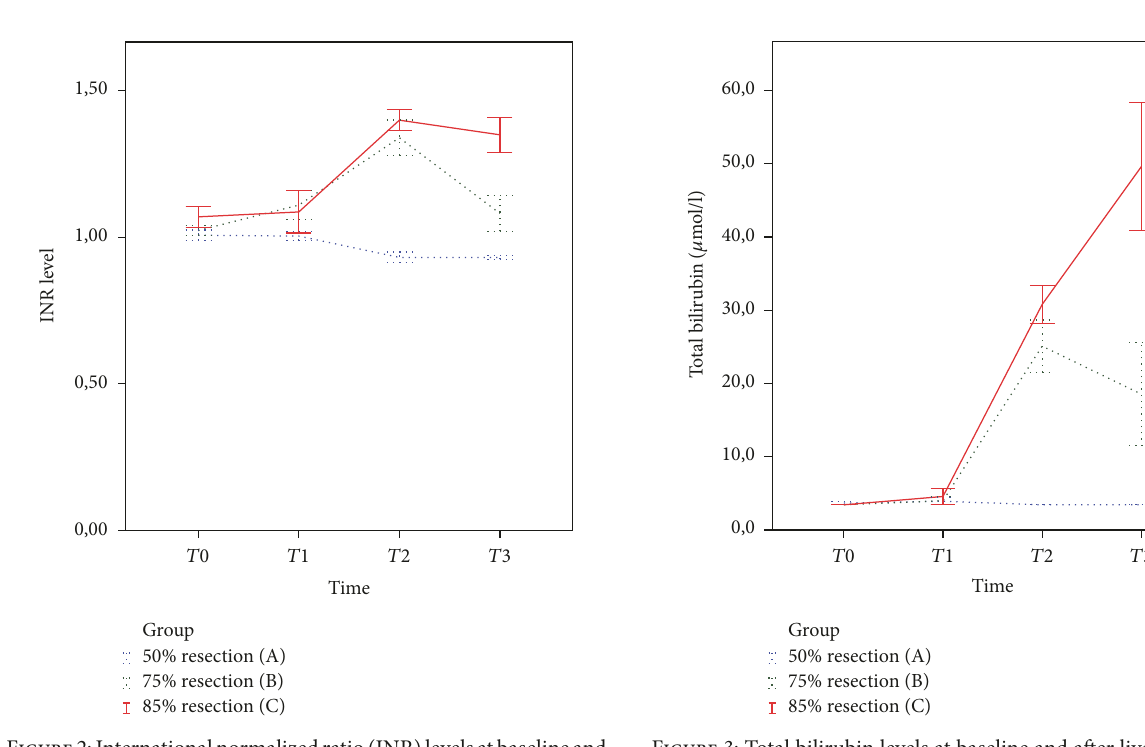
Figure 3: Total bilirubin levels at baseline and after liver resection. 𝑇0 (baseline, 𝑝 = 0.559 ); 𝑇1 (one hour after surgery, 𝑝 = 0.804 ); 𝑇2 (one day after surgery, 𝑝 < 0.001 ); 𝑇3 (at sacrifice, 𝑝 < 0.001 ). Total bilirubin levels were significantly lower in group A compared with groups B and C ( 𝑝 < 0.001 ) at different time points. Error bars show standard error of the